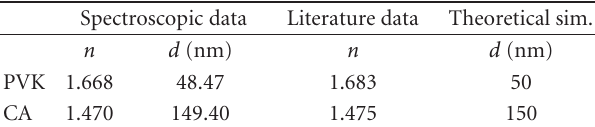
Table 1: Refractive indexes and thicknesses of the polymers in the 1D PC. Comparison with literature and theoretical